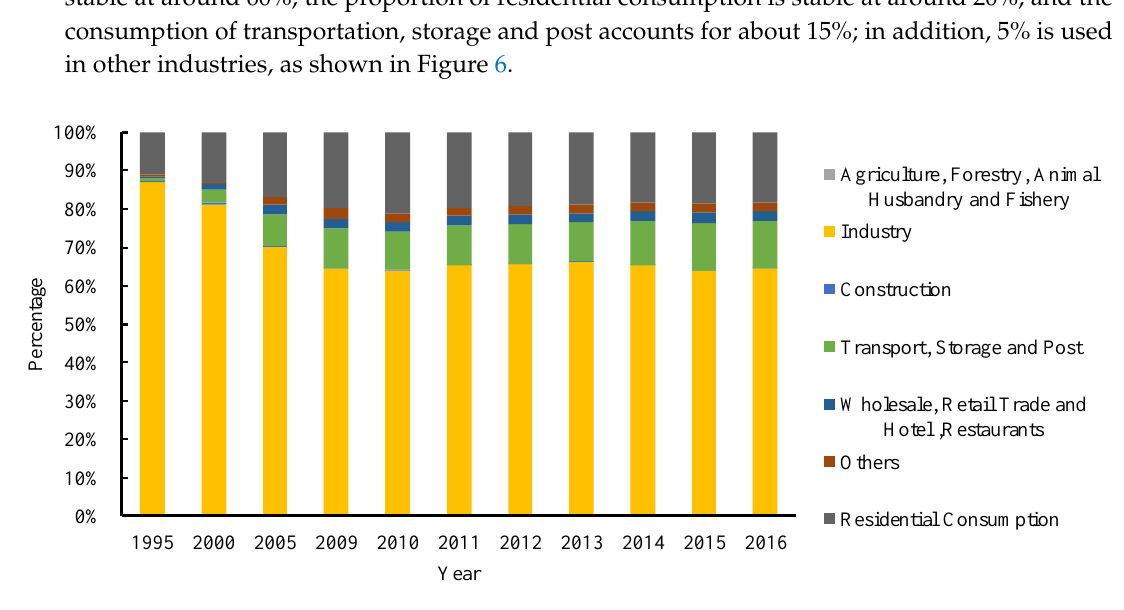
Figure 6. China’s Natural Gas Consumption by Industry Figure6. China's Natural Gas Consumption by Industry (%). Figure6. China's Natural Gas Consumption by Industry (%).